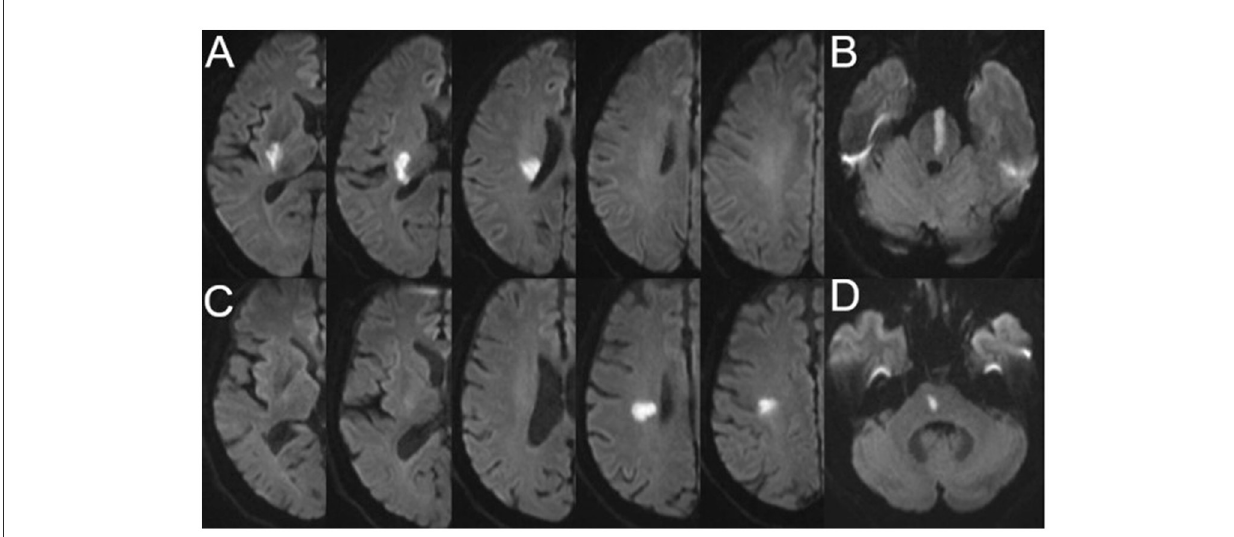
FIGURE1 Representative cases of pSSI and dSSI. (A) pSSI in the anterior circulation; (B) pSSI in the posterior circulation; (C) dSSI in the anterior circulation; and (D) dSSI in the posterior circulation. pSSI, proximal single subcortical infarction; dSSI, distal single subcortical infarction.